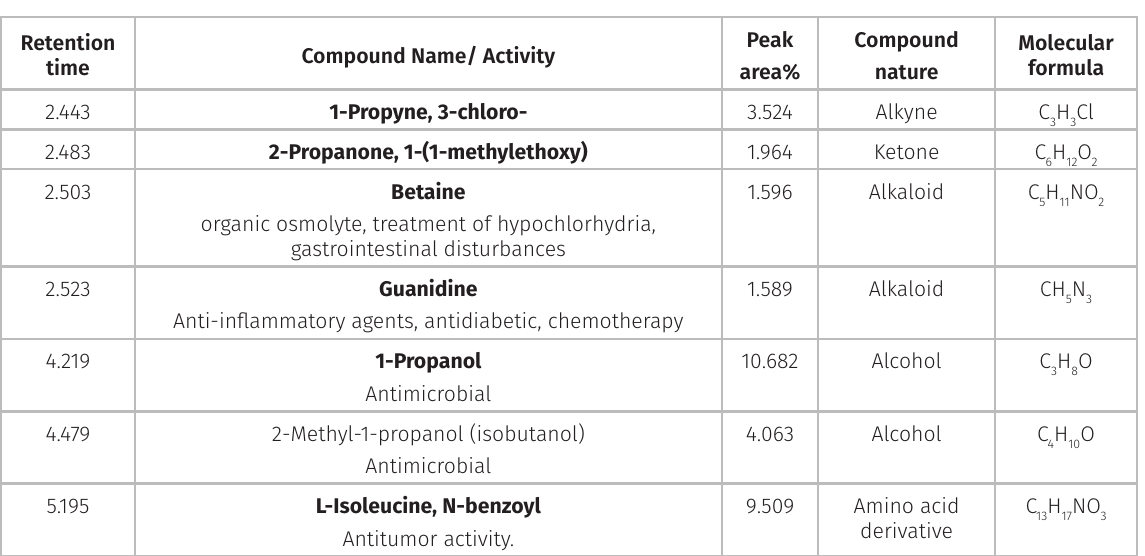
Table VI. GC-MS analysis of Spirulina platensis methanolic extract